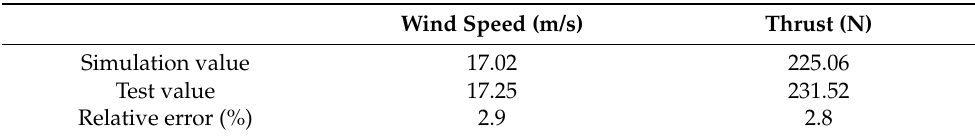
Table 8. Comparison of simulated and experimental values.